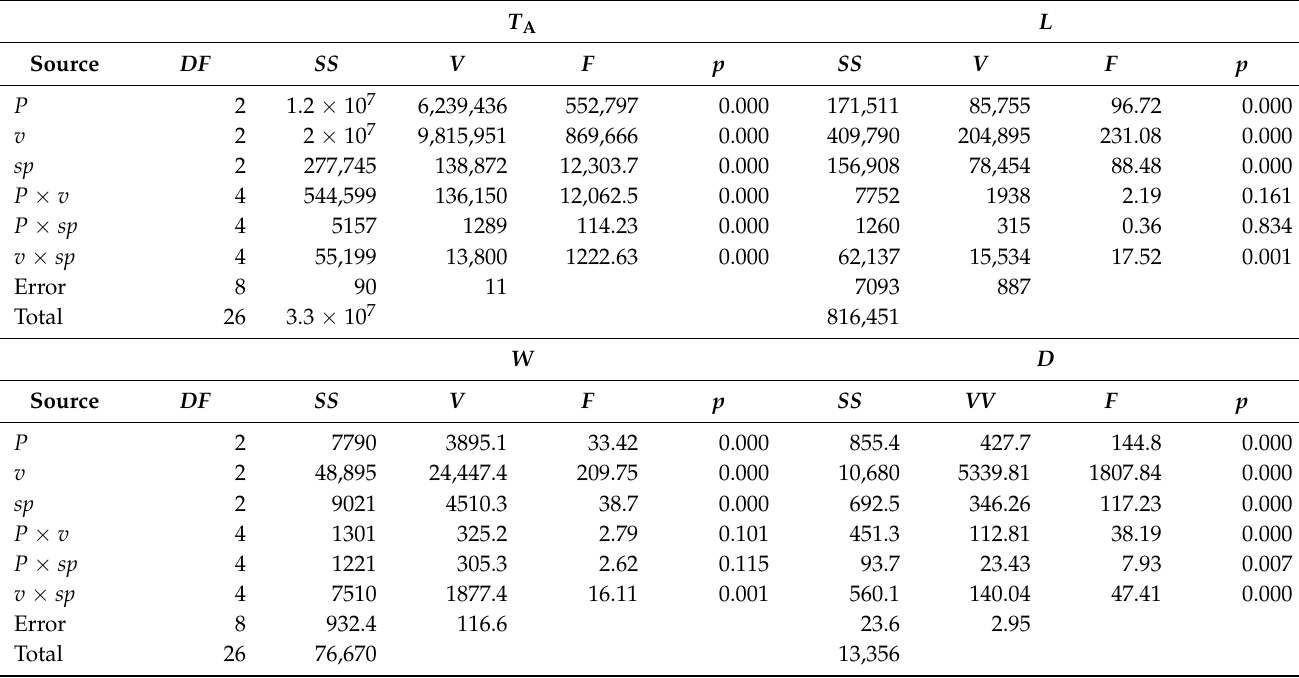
Table 4. ANOVA result for the studied responses.